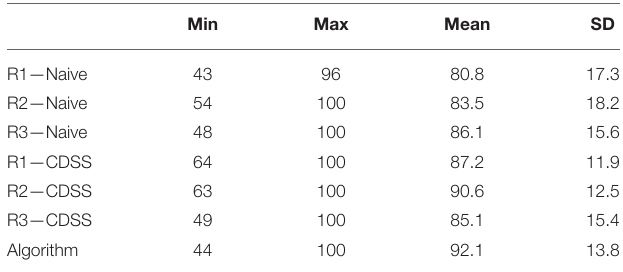
subjects, Figure 5 —Algorithm, Figure 6 —filled black